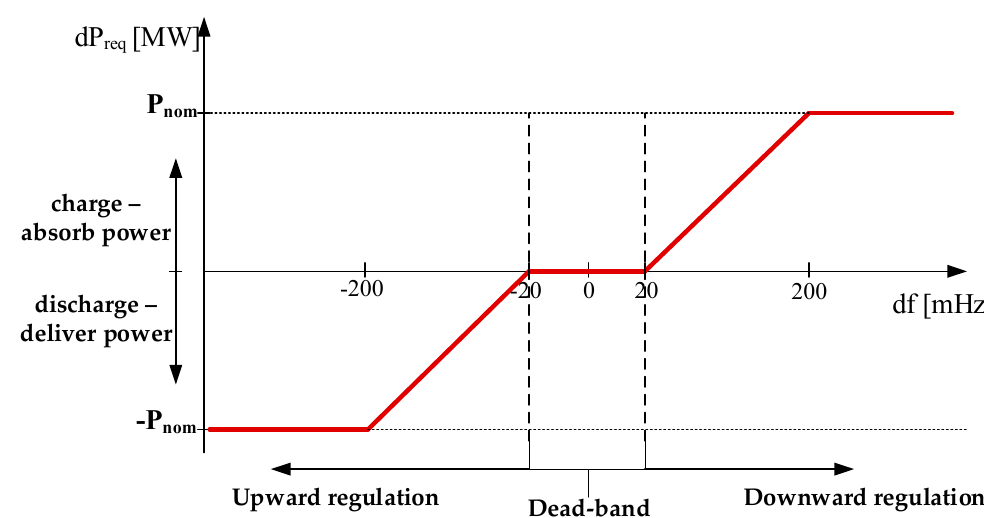
Figure 4. Droop characteristic of BESS unit participating in the provision of FCR.